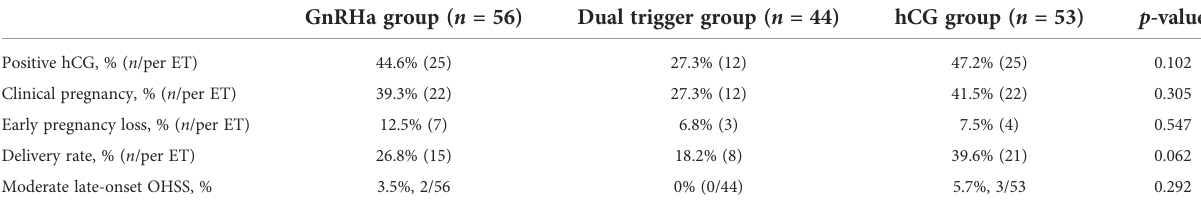
TABLE 8 Clinical outcomes and ovarian hyperstimulation syndrome